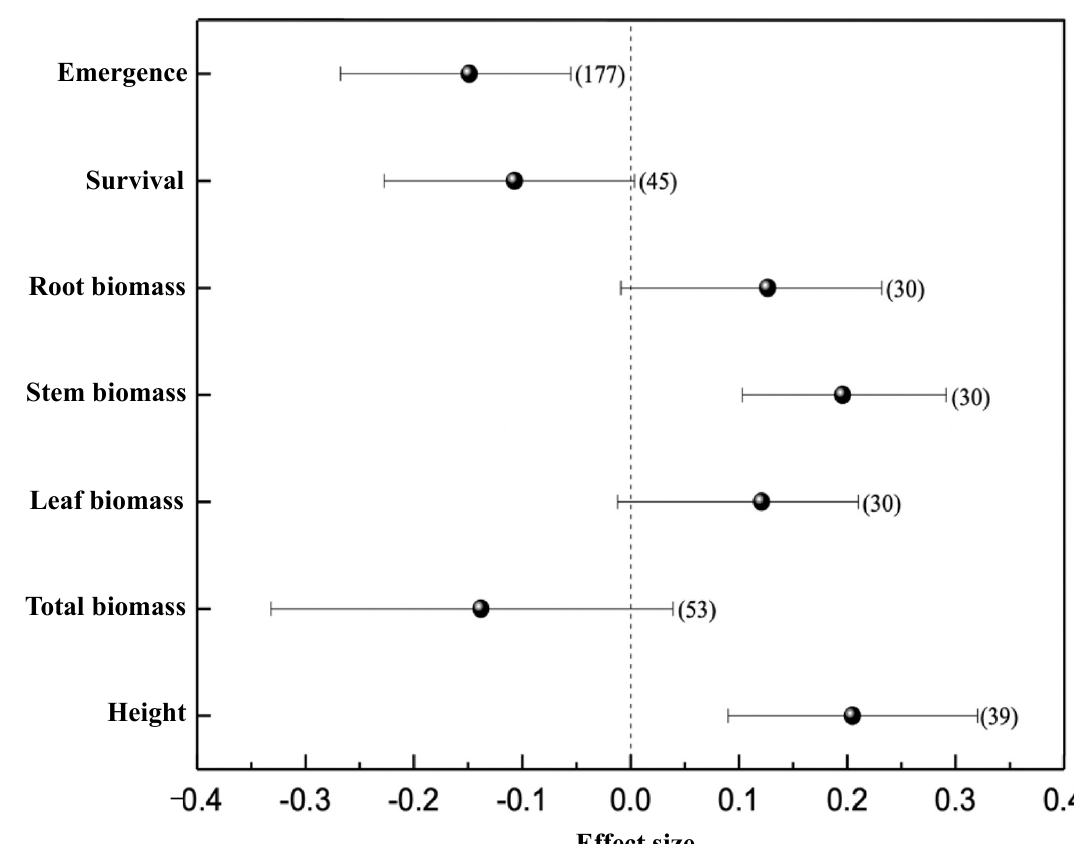
Figure 2. Mean effect size for each seedling-related trait under litter cover. The numbers in brackets represent the sample size of each indicator. An effect size > 0 indicates a positive effect of litter cover, while values < 0 indicate a negative effect. Error bars are 95% confidence intervals (CI).